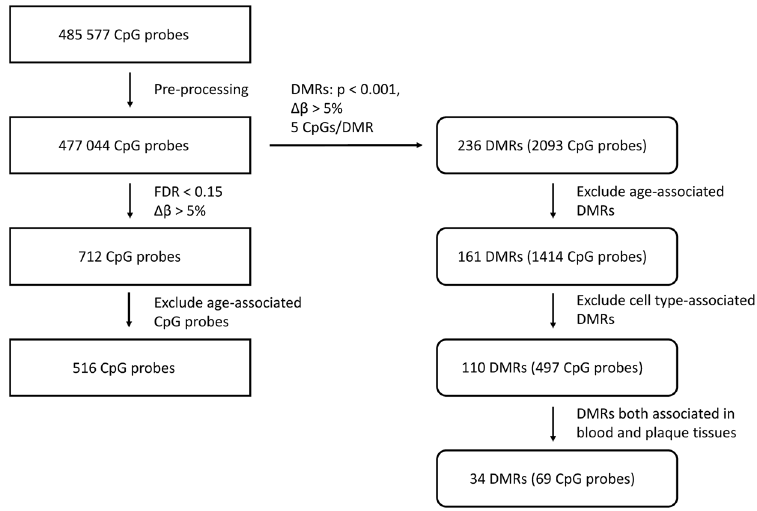
Figure 1. Flowchart of DMP and DMR selection.